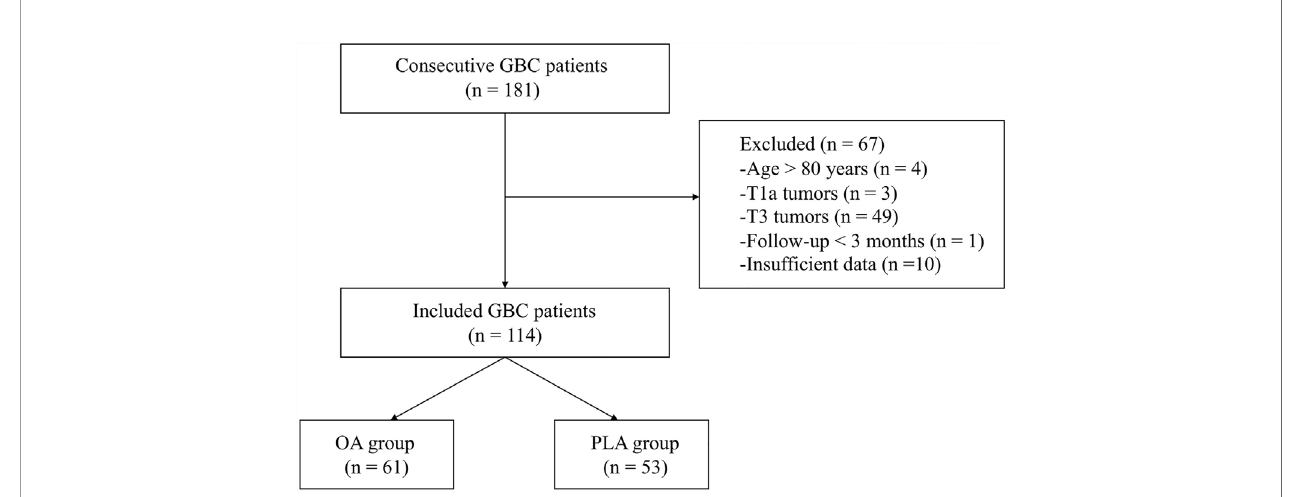
FIGURE 1 | A fl ow diagram of the included patients. GBC, gallbladder cancer; OA, open approach; PLA, primary laparoscopic